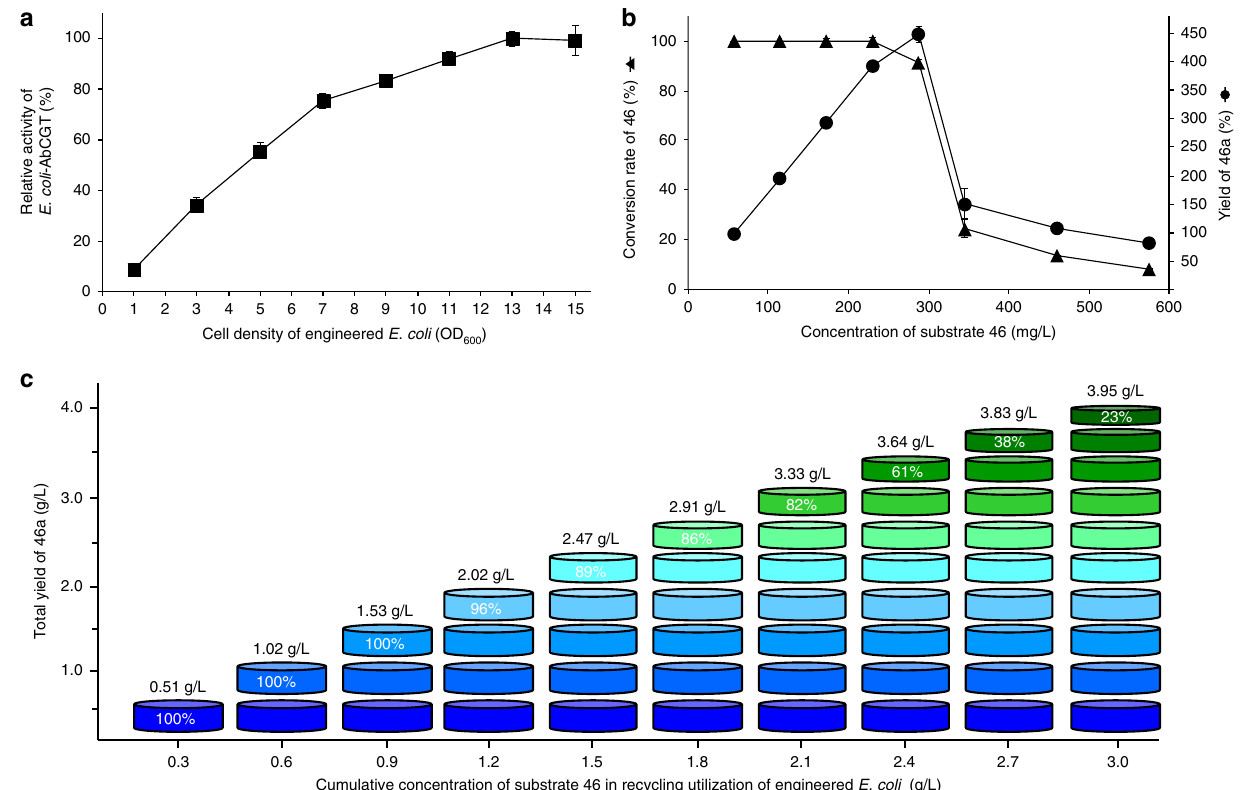
Fig. 4 Optimizing the cell density and substrate concentration and exploring the recyclability and stability of the biocatalytic system. a The effects of cell density to the catalytic activity of E. coli-AbCGT . b The effects of substrate concentration to the conversion rate of aglycon 46 and production of C - glycoside 46a . c Recycling utilization of engineered cells with aglycon 46 ( fi nal concentration 0.3 g/L/round) for ten rounds in production of C -glycoside 46a . Reactions were performed at 25 °C in M9 medium for 12 h with shaking (180 rpm). The total yield of 46a and the conversion rate of 46 for each round are indicated. The relative activity ( a ) and conversion rates ( b ) represent mean ± SD of three independent replicates ( n = (PDB entry, 6L5R.1), a di- C -glycosyltransferase 32 . It is reported